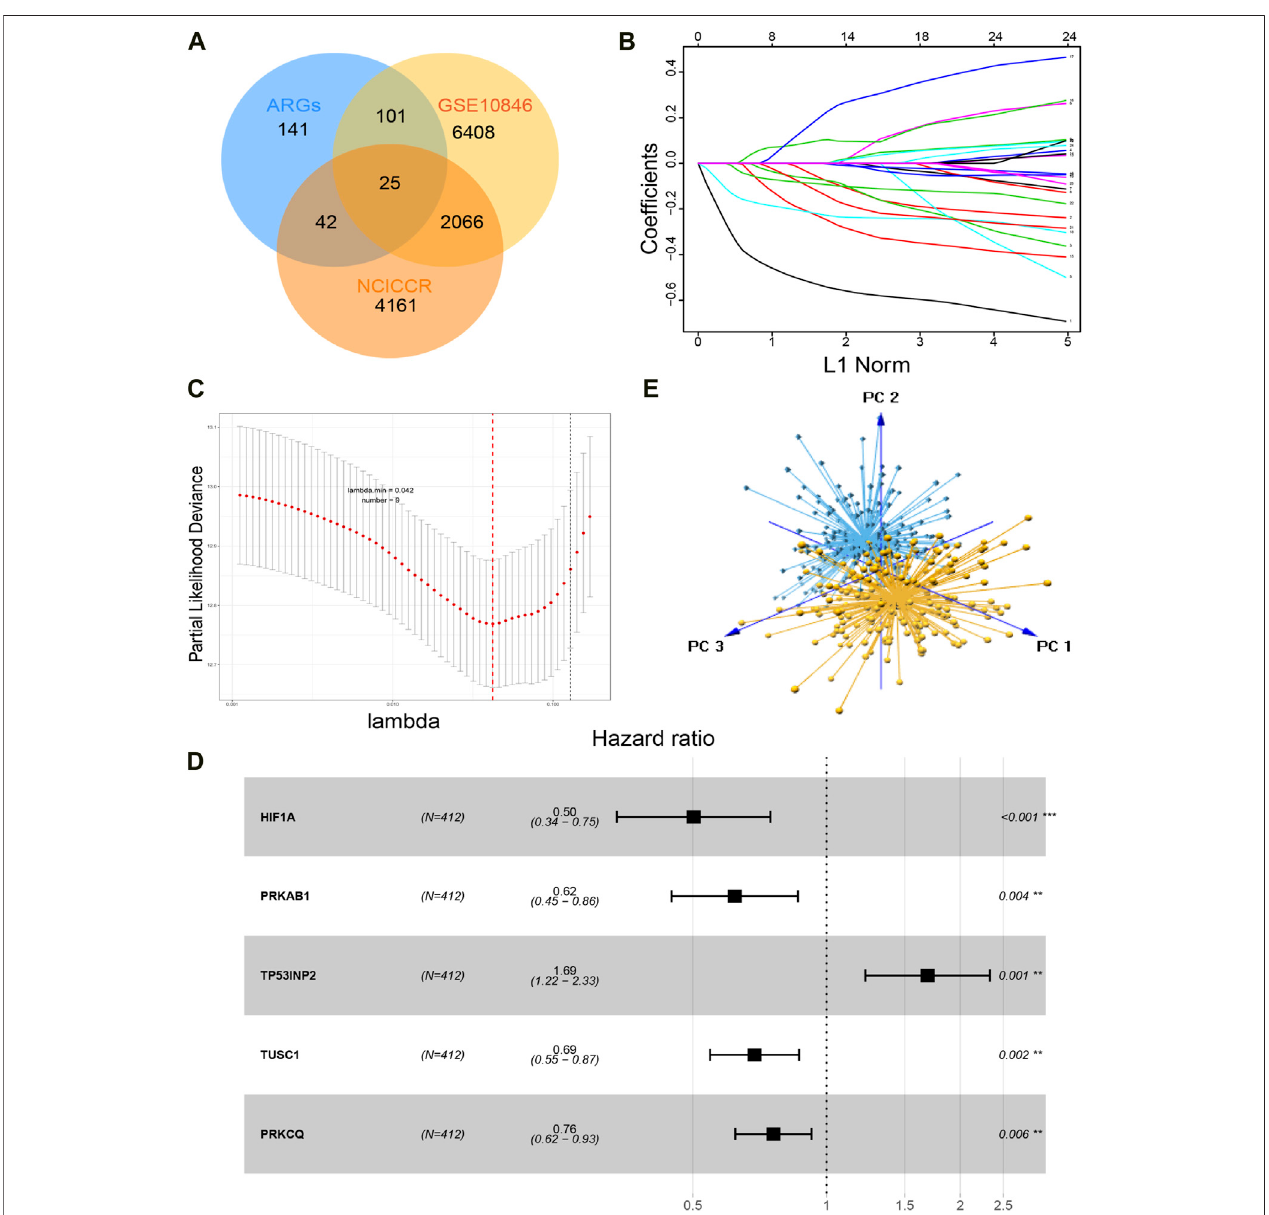
FIGURE 3 | Construction of the gene signature. (A) Overlapped genes generated by autophagy-related genes and prognosis-related genes of GSE10846 and NCICCR datasets. (B) LASSO coef fi cient pro fi les of the 25 overlapped genes. (C) Nine genes are selected by LASSO Cox regression analysis. Two dotted vertical lines are drawn at the value of minimum criteria and 1-s.e criteria of cross-validation, respectively. (D) Five genes that make up the gene signature and their corresponding hazard ratios resulting from multivariable Cox regression. (E) Principal component analysis of the fi ve autophagy-related genes between high-risk and low-risk patients. Low-risk samples are marked in blue, and high-risk samples are marked in